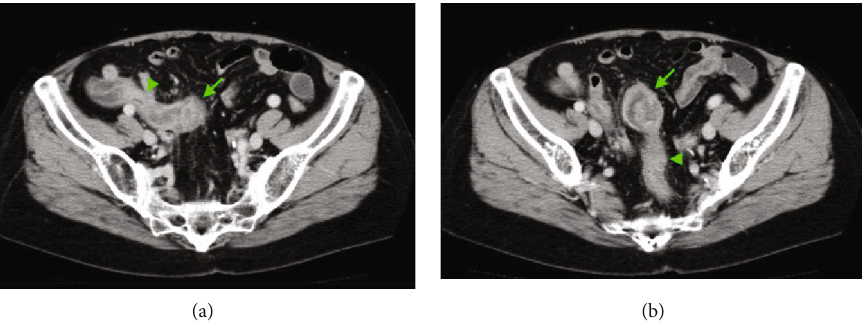
Figure 2: CT fi ndings. (a) An appendiceal mass was seen at the distal part of the appendix. The appendiceal mass and the appendix are indicated by an arrow and an arrowhead, respectively. (b) The appendiceal mass involved the sigmoid colon. The mass and the normal rectosigmoid region are indicated by an arrow and an arrowhead,